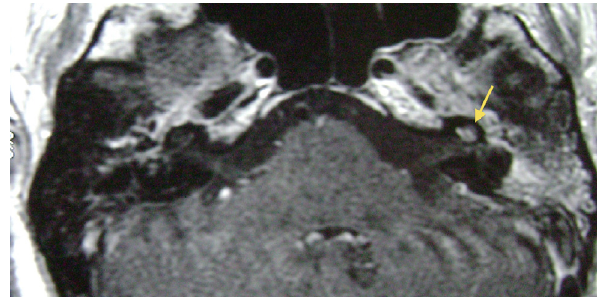
Figure 3 NMR weighted in T1 with gadolinium. Enhance- ment of contrast in the left cochlea (arrow) in a patient with Wegener’s granulomatosis. Note : enhanced contrast in the mid- dle ear. Patient with associated